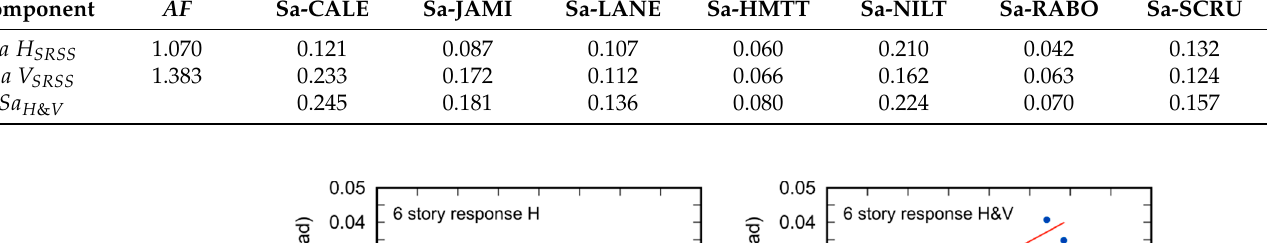
Table 9. Resultant accelerations of the horizontal plus vertical components (10-story building).